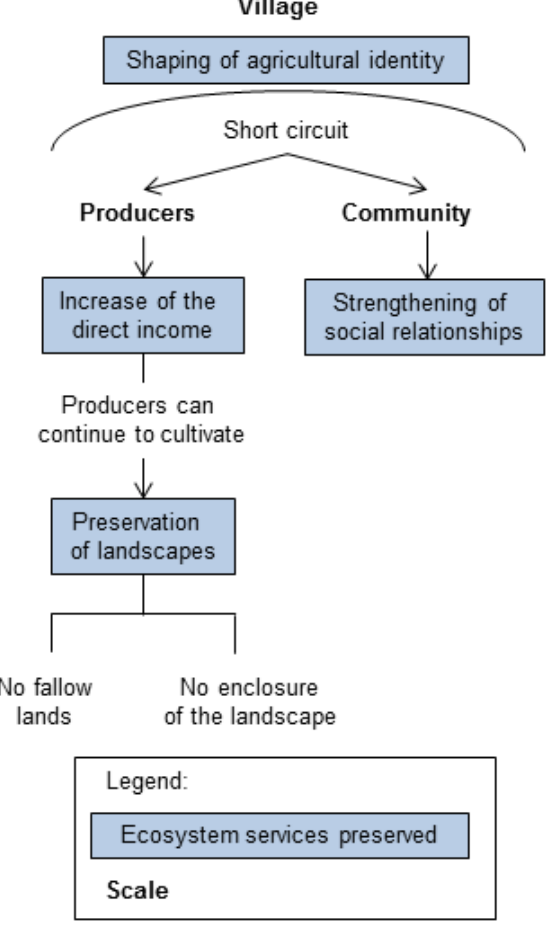
Fig. 3 . Villeveyrac’s systemic vision of agriculture. This diagram illustrates how “short-circuited” agriculture in Villeveyrac impacts producers, the community, and the village as a